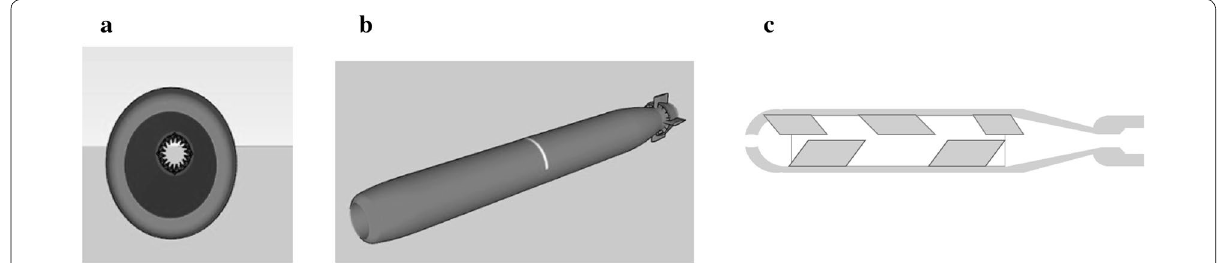
Fig. 1 3D PLA prototype. Front view ( a ), external view ( b ), and longitudinal section ( c